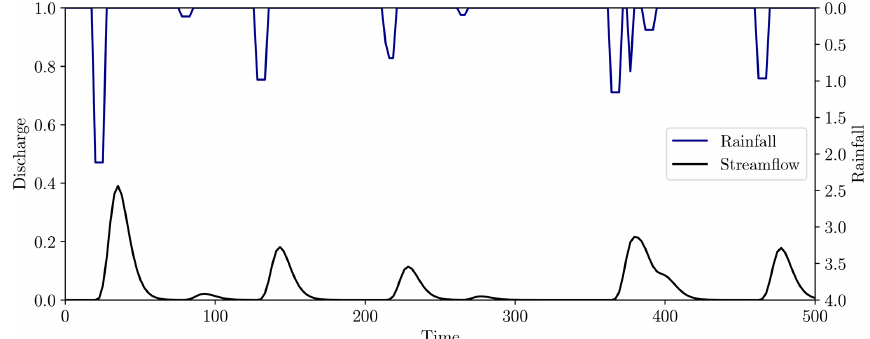
Figure 16. Effective rainfall (top, blue) and observed streamflow (bottom, black) for the test problem. Rainfall was generated using the method described in Appendix A with 10 rainfall events of maximum length five time units. The streamflow was generated using the unit hydrograph model Eq. (24) with model parameters (3, 5).